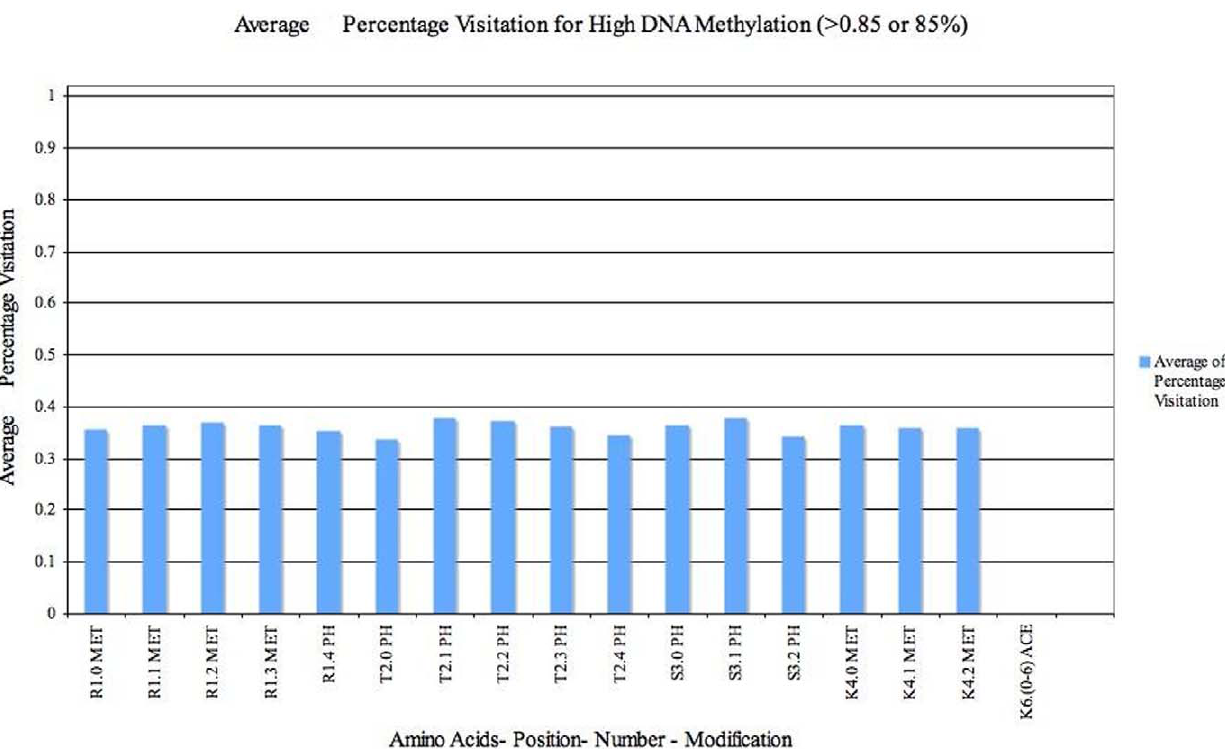
Figure 7. Analysis of Average percentage visits of H3 histone states containing LysineMethylationi.e.K5 in 16 promoters after 5000 iterations (for high levels of DNA Methylation ( , 0.85 or 85%)). States containing Lysine Methylation are visited the most. Hence we analyse the average of percentage visitation of model to all other modifications (except Lysine Methylation K5) during the simulation. Each unit in the X-axis represents an amino acid–position in H3 array–number of Amino acids changeable–Modification. The Y axis elaborates on the average percentage visitation of H3 states that contain the modification given on the X axis.